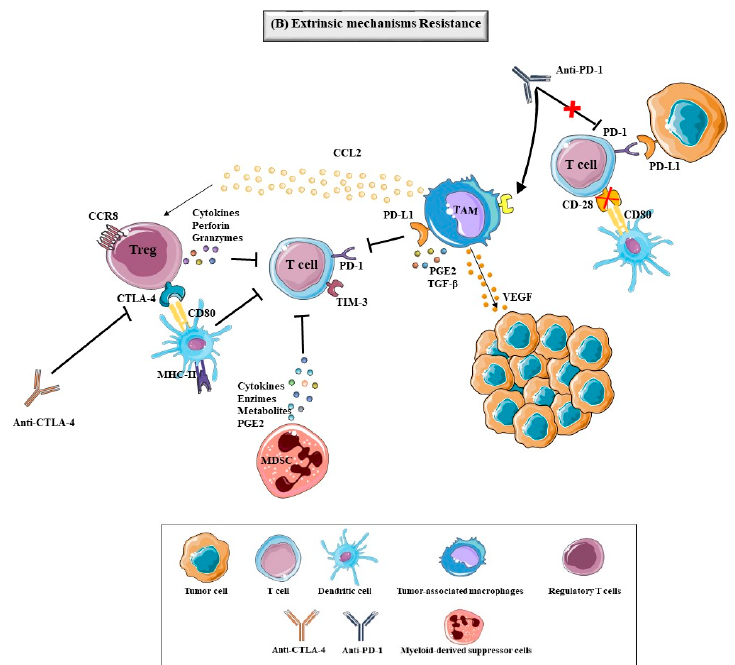
Figure 4. Extrinsic mechanisms of tumor resistance to immunotherapy. The presence of determinate components in TME, like immunosuppressive cells and some molecules, influenced by the tumor can lead to immunotherapy resistance. The Treg cells, characterized by the expression of the FoxP3, are one of these components and they can inhibit MHC molecules and CD80/CD86 on the surface of APC and secrete cytokines, perforin and granzymes that inhibit the activation and proliferation of T cells effectors and APC. The MDSC are a group of cells of type myeloid origin involved in TME, that have a potent immune-suppressive activity by inhibiting the T-cell function with the production of immunosuppressive metabolites, immunosuppressive cytokines, immunoactive enzymes, and immunosuppressive prostaglandin E2 (PGE2), contributing to the progression, invasion and metastasis of the tumor. The TAM (M1 and M2 macrophages) are other types of cells that can infiltrate around tumor cells, due to the action of VEGF and chemokines, and the overexpression of PD-L1, PGE2, TGF- β and CCL2 (promote the accumulation of Treg) affect responses to immunotherapy. In a study, it was demonstrated that TAM can capture anti–PD-1 from the surface of T cells, leading to the resistance of the PD-1 inhibitor. The expression of immune checkpoints can mediate tumor immune resistance, Tim-3 being one of these and expressed in T cells, whereby the upregulation of this immune checkpoint after the PD-1 blockade lead to the inhibition of the activation of T cells, decreasing immunotherapeutic response. The loss of expression of CD28, the homologue of CTLA-4 that promotes the activation of T cells, can cause the T cells lost capacity to proliferate and perform the normal activity, contributing to the immunotherapeutic resistance. Abbreviations are as follows: Cytotoxic T-Lymphocyte Associated Protein-4 (CTLA-4), Antibody Cytotoxic T-Lymphocyte Associated Protein-4 (Anti-CTLA-4), Tumor-Associated Macrophages (TAM), Myeloid-Derived Suppressor Cells (MDSC), Regulatory T